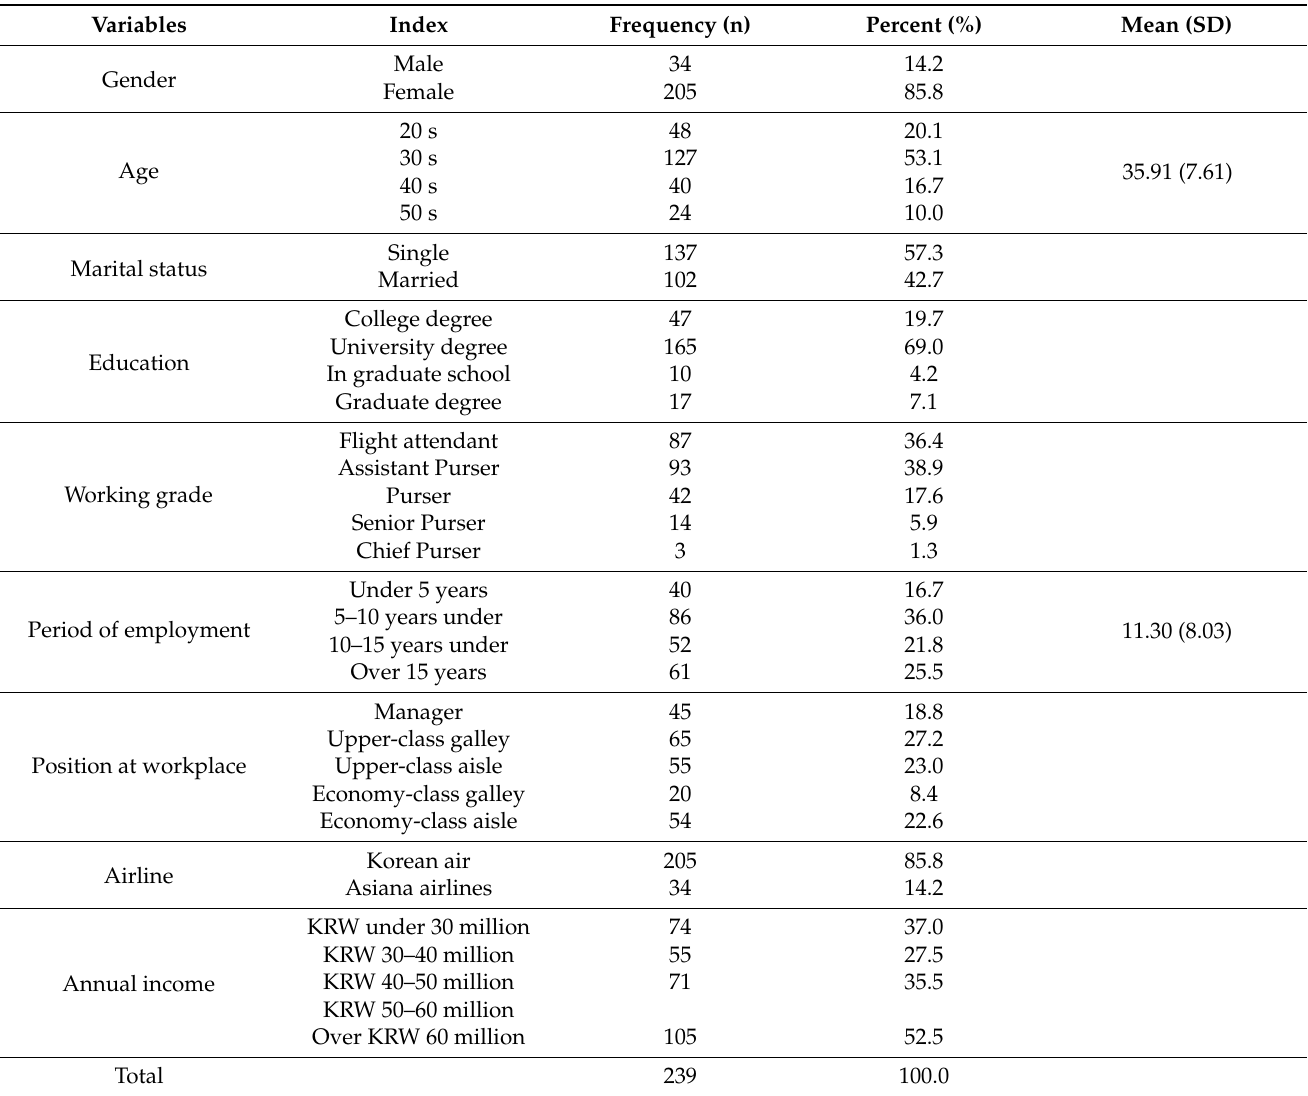
Table 1. Characteristics of the Subject